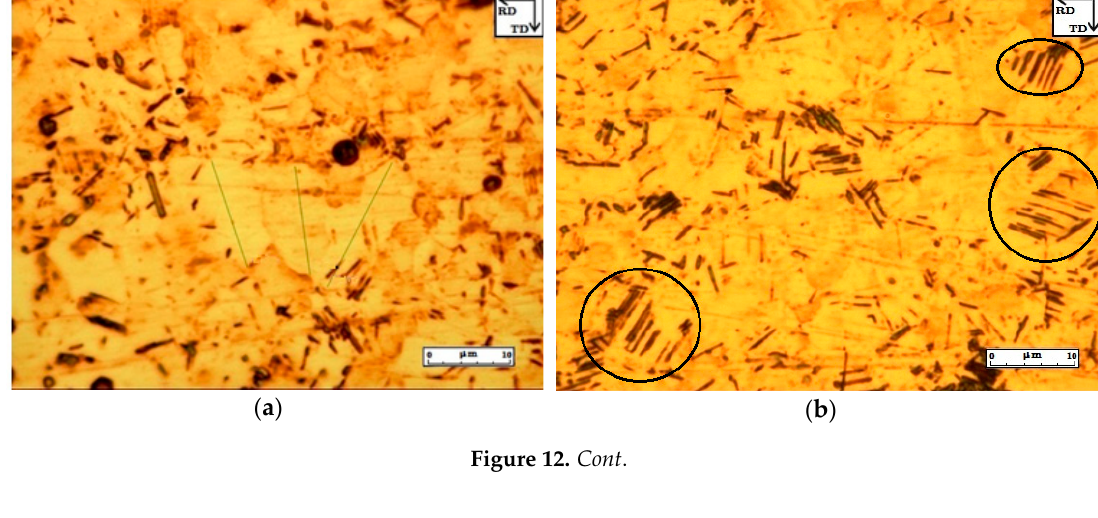
Table 1. Mechanical properties obtained in each test scenario.